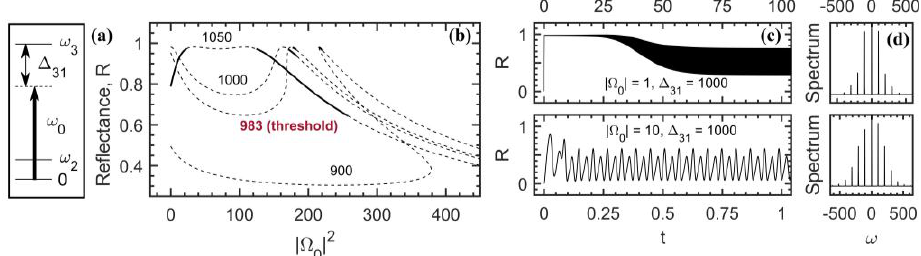
Fig. 2. (a) – Scheme of QE excitation. (b) – The steady-state layer’s reflectance R calculated for a set of the detuning Δ 31 (shown in the panel). Solid (dashed) parts of the curves indicate regions of stability (instability) of R. (с) and (d) – Dynamics and Fourier spectra, respectively, calculated for the values of |Ω 0 | shown in the panel (с). All quantities are given in units of γ 31